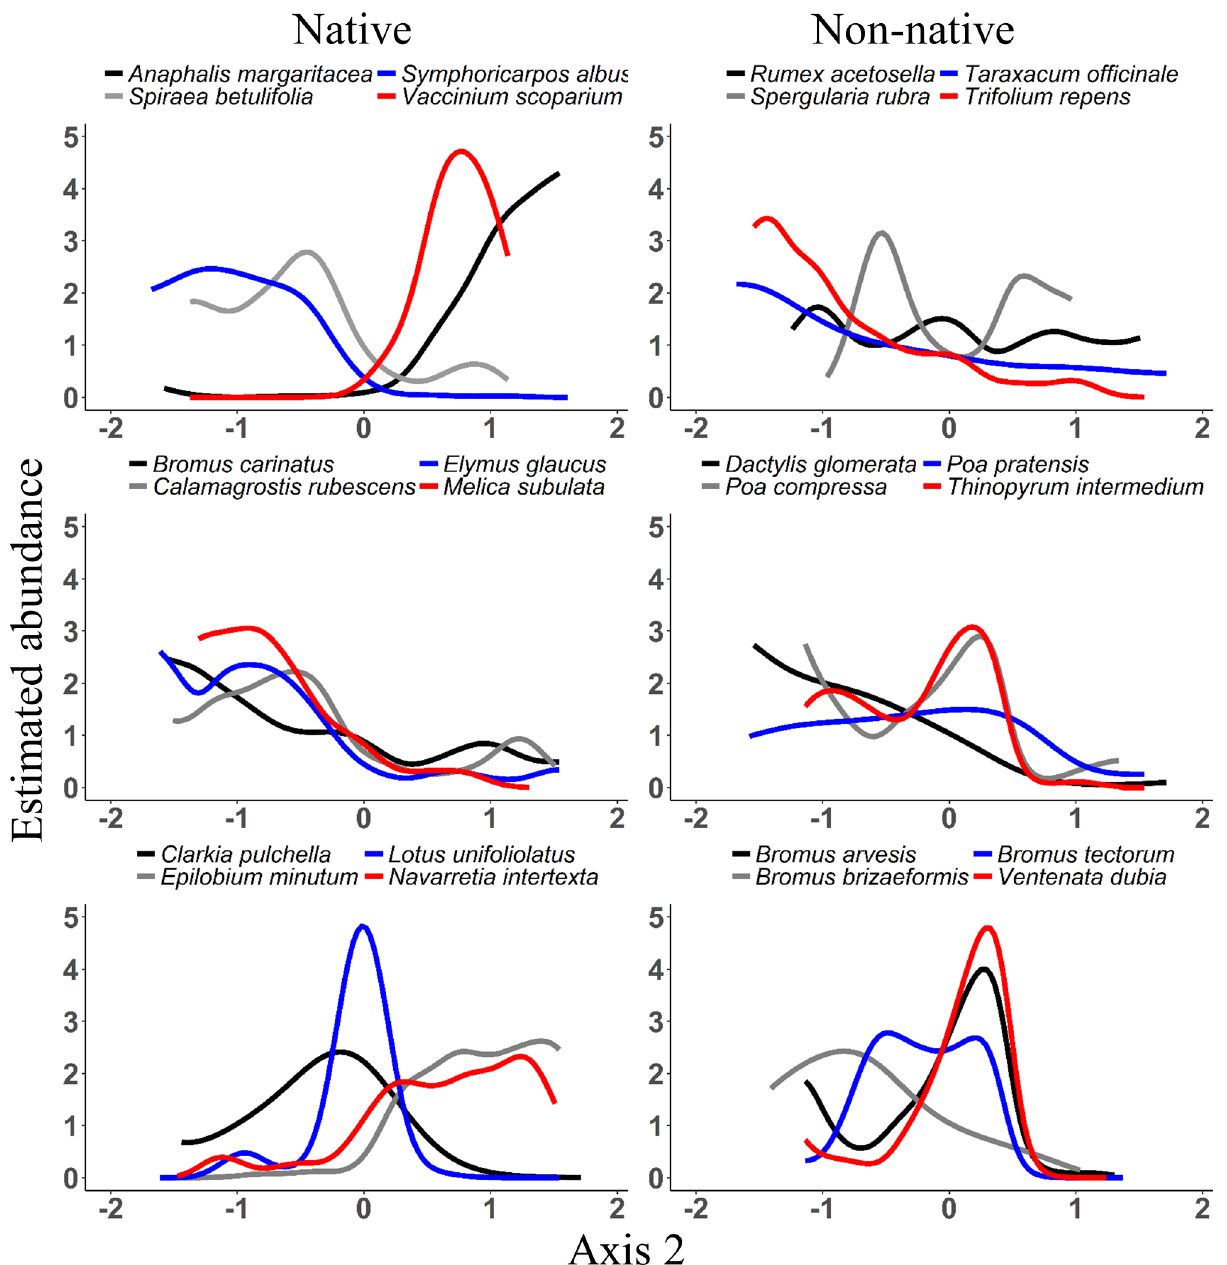
Fig 3. NPMR response curves for selected species along NMS Axis 2 (elevation gradient). Estimated abundances were relativized by the maximum value for each